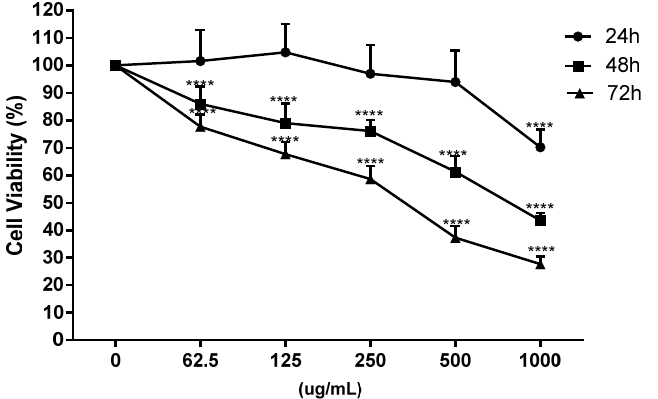
Figure 2. Dose-response curve of cell viability in Caco-2 cells at different incubation times (24, 48 and 72 h) and concentrations (0, 62.5, 125, 250, 500 and 1000 µg/mL) with onion waste extracts (**** p < 0.0001).